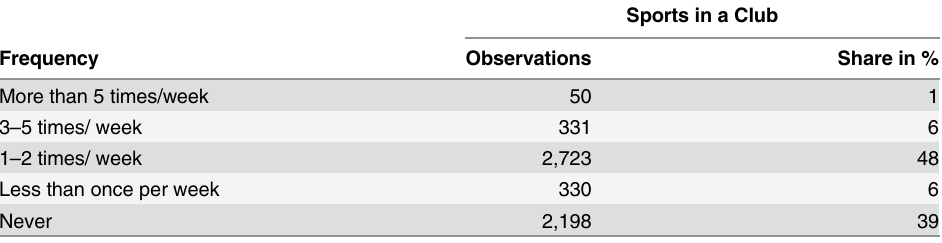
Table 2. Frequency of participation in a sports club. Note: Computed from our estimation sample of